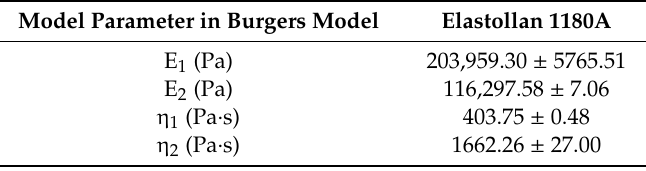
Table 12. Applicability of different model systems for PCL filled 3% ( w/v ) alginate solution.